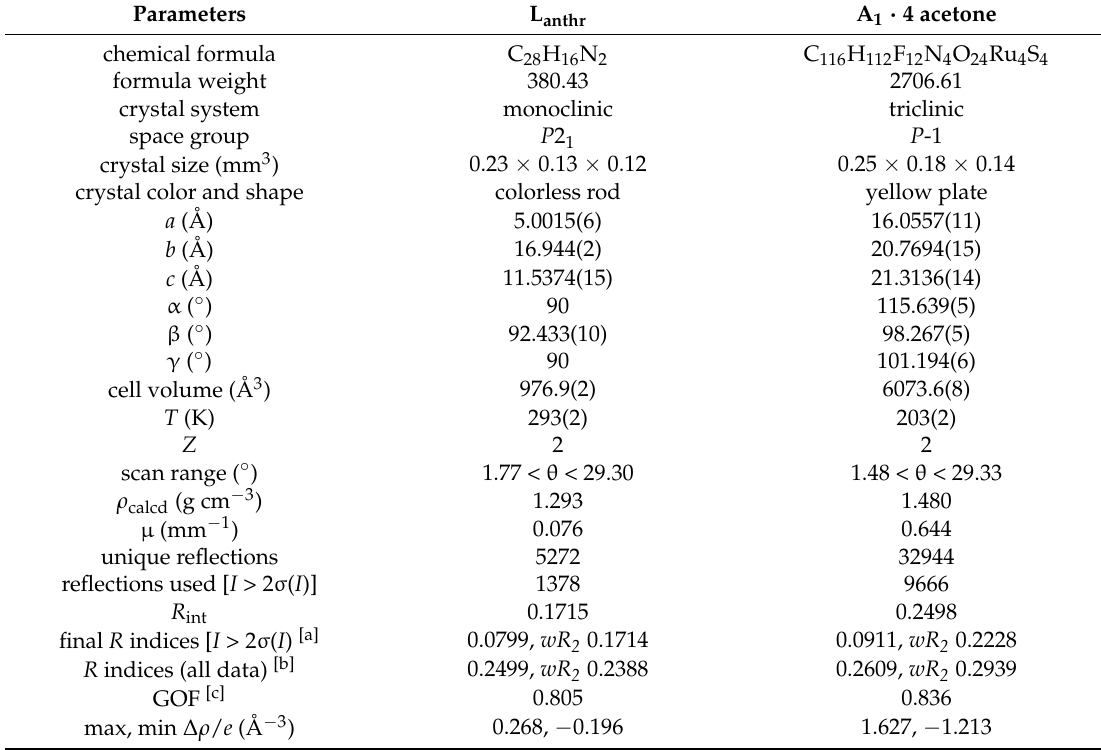
Table 2. Crystallographic data and structure refinement parameters for L anthr and A 1 · 4 acetone.